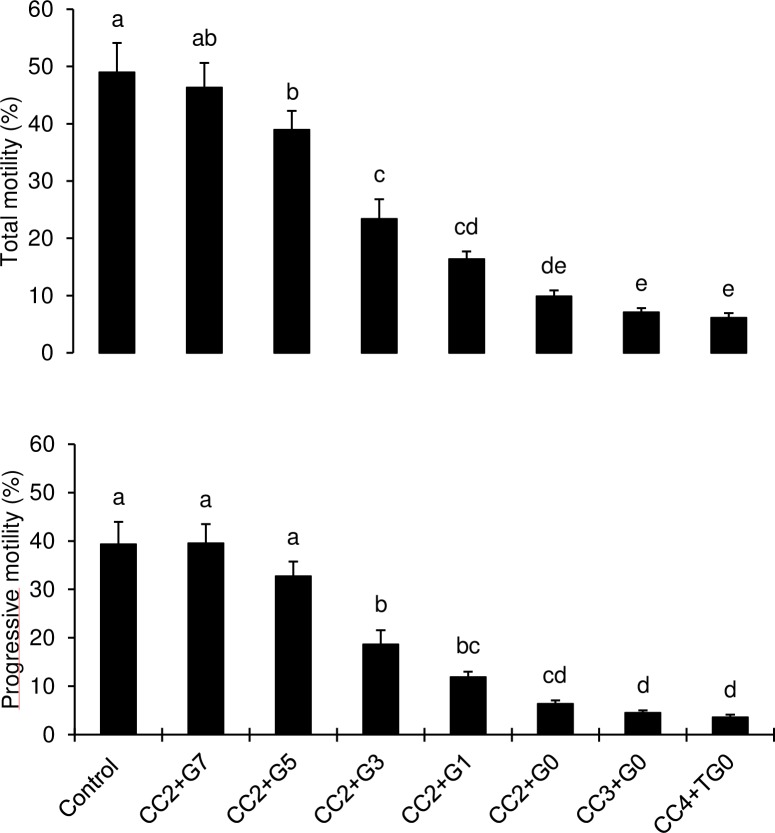
Effect of different concentrations of cholesterol-cyclodextrin complex and glycerol on post-thaw sperm total motility and progressive motility.Each bar represents mean±SEM of five pooled ejaculates (replicates) from four bulls. Bars with different letters (a-e) within a sperm motility characteristic differ from each other. Number (2, 3 or 4) following letters CC represents concentration of cholesterol-cyclodextrin complex (mg/ml). Number (7, 5, 3, 1 or 0) following letter G represents glycerol concentration in TG extender.